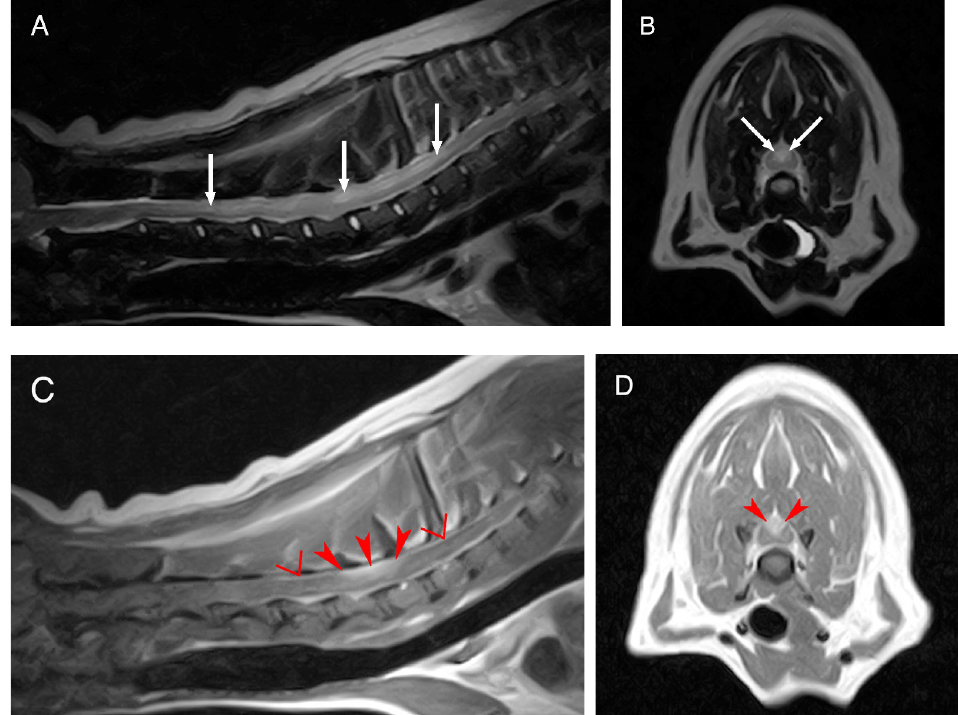
Figure 1. MRI of the dog’s cervical region. Midsagittal T2W image ( A ), transverse T2W image at the level of C6–C7 ( B ), mid sagittal T1W post contrast image ( C ) and transverse T1W post contrast image also at the level of C6–C7 ( D ). The white arrows are pointing to the T2-weighted hyperintense, intramedullary lesion extending from C3 to T3. The red arrowheads show the marked contrast enhancement in the dorsal portion of the spinal cord at the level of C6–C7. The red inverted triangles show the meningeal contrast enhancement.